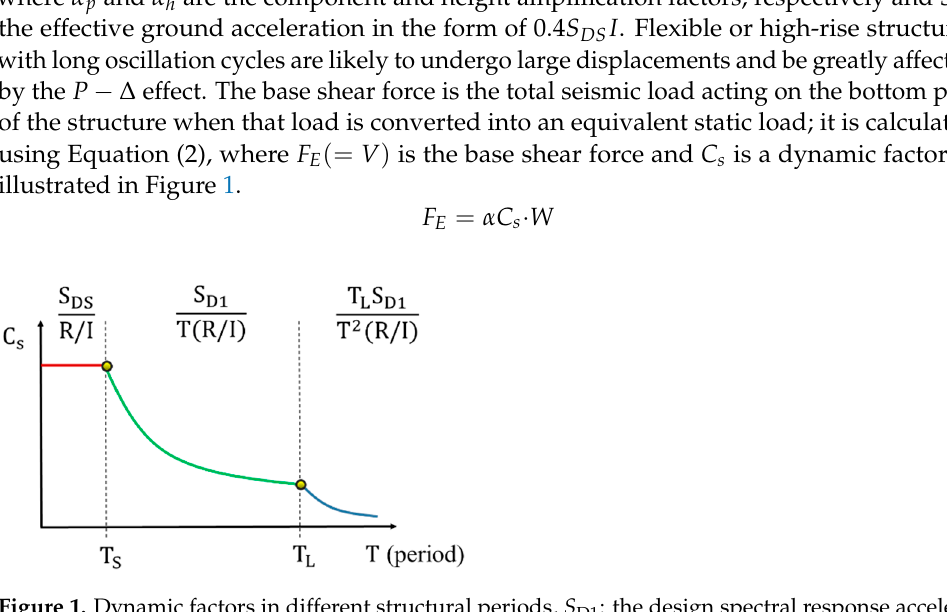
Figure 1. Dynamic factors in different structural periods, S D1 : the design spectral response accelera- tion parameter at a period of 1.0 s.